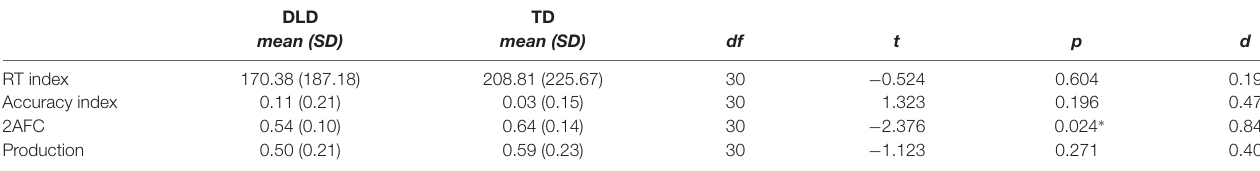
TABLE 7 | Independent-samples t -test analyses for each learning index of the visual non-verbal segmentation task.